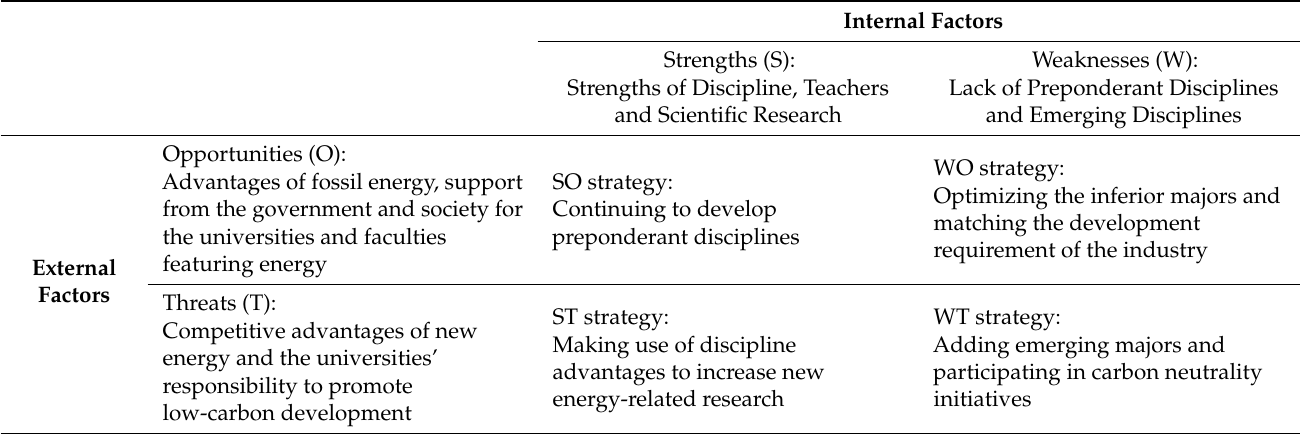
Table 1. The SWOT analysis framework applicable to the specialty structure adjustment of the universities and faculties featuring energy. Internal Factors Weaknesses Strengths (S): Strengths of Discipline, Teachers and Scientific Research